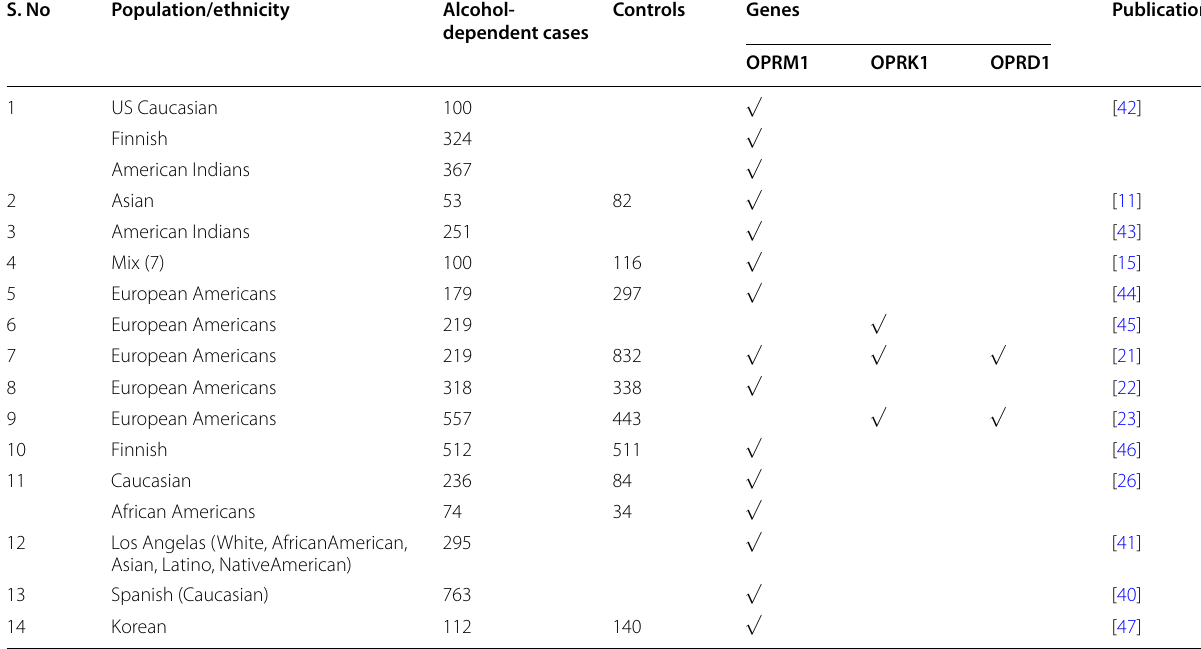
The table explains the association and pathway studies of alcohol-dependent cases and controls in the genes OPRM1 , OPRK1 and OPRD1 in different populations